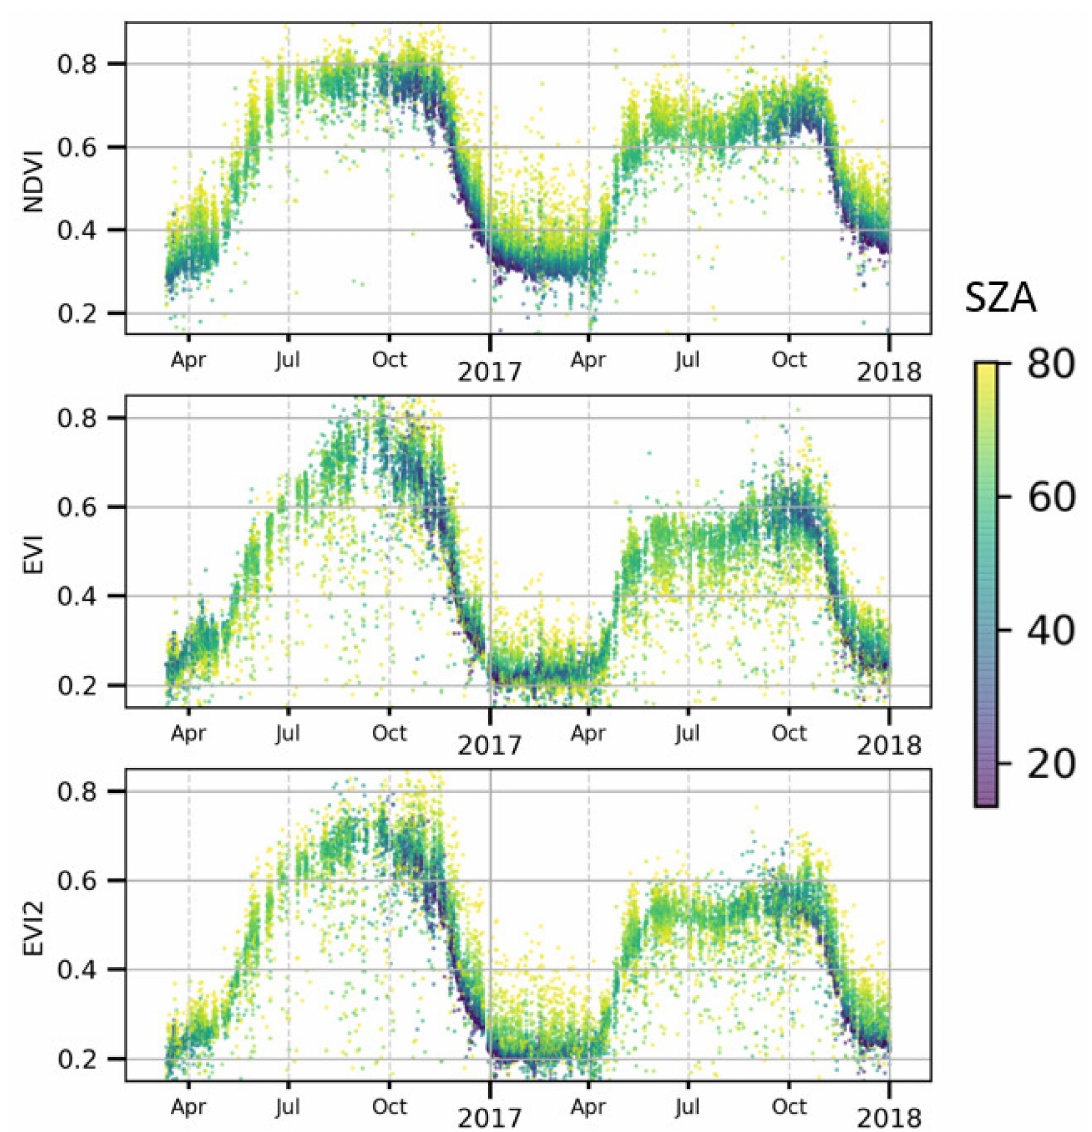
Figure 7. AHI 10-minute NDVI, EVI and EVI2 values over the Redesdale site for the 2016 and 2017 grass growing seasons. The color scale depicts the diurnal and seasonal solar zenith angle (SZA) geometries of the